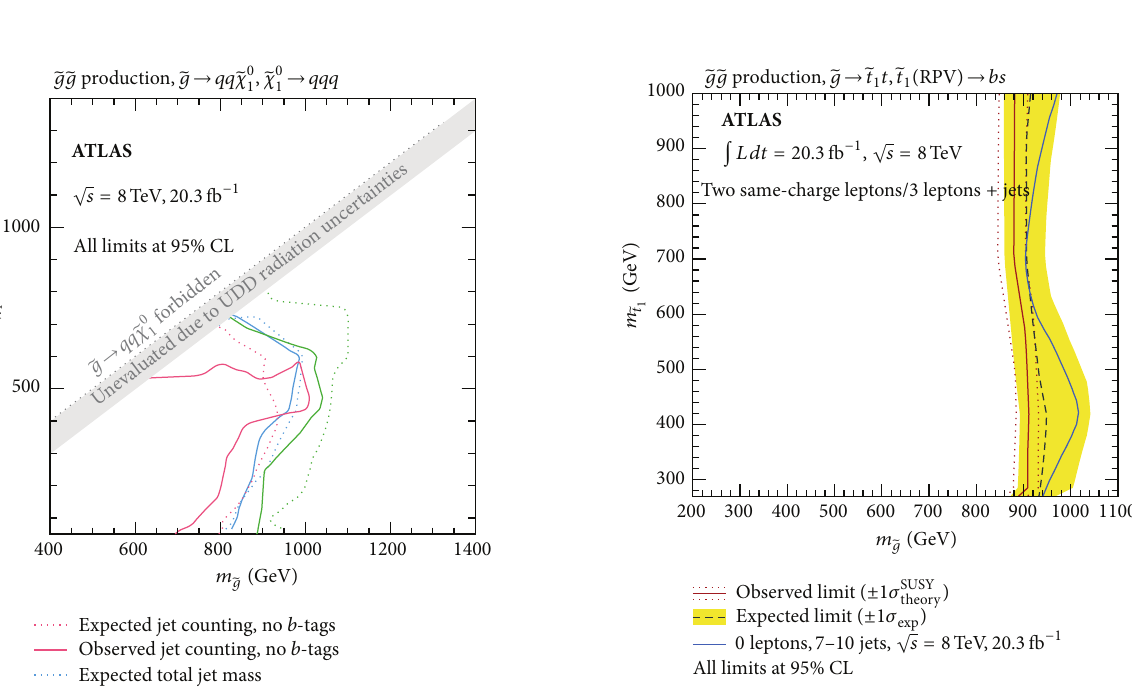
Figure 15: Observed and expected exclusion limits on gluino- mediated top squark production, obtained with 20.3 fb −1 of 𝑝𝑝 collisions at √𝑠 = 8 TeV, for the top squark decay modes via 𝜆 󸀠󸀠 323 ) (from 1